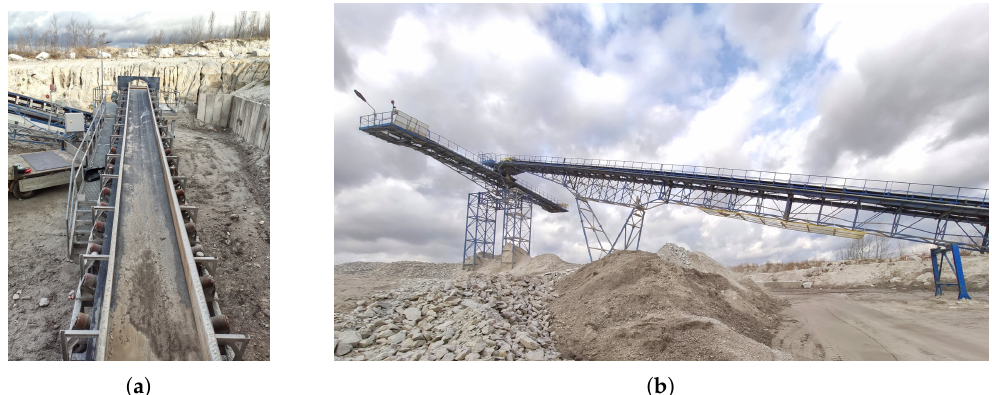
Figure 1. Conveyorsconnectedbyanalyzedtransferstation: ( a )feedingconveyorbeltWD-1and( b )receiving conveyor belt